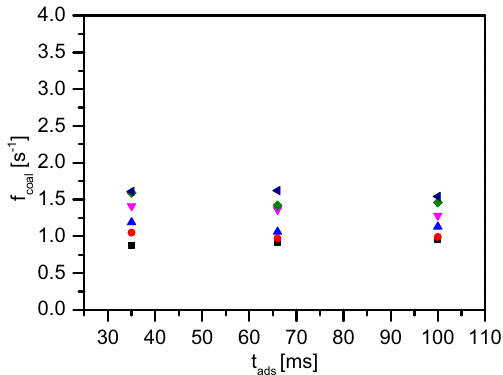
Figure 6. Coalescence trends with different adsorption time: 35 ms, 66 ms and 100 ms, at various temperatures. The data shown here are all at 0.5 mM SDS concentration. Different symbols denote the various temperatures at which the coalescence was measured: 20